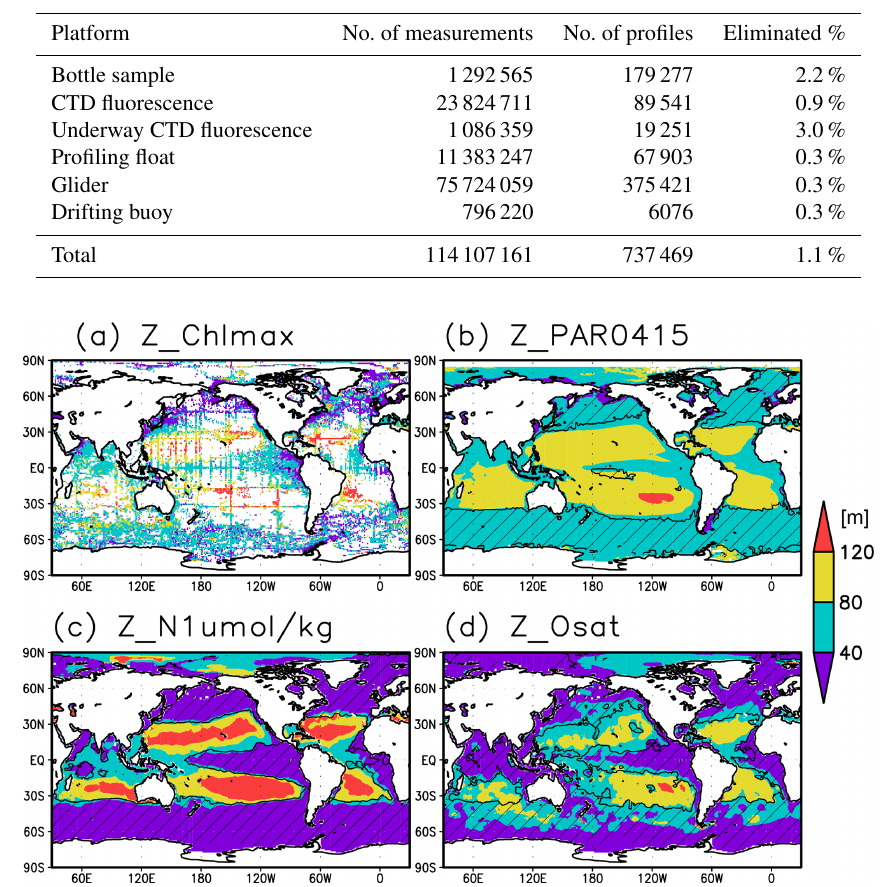
Figure 2. Depths of (a) the chlorophyll a (Chl a ) maximum, (b) the photosynthetically active layer ( > 0 . 415molm − 2 d − 1 of photosyn- thetically available radiation), (c) the nitrate-depleted layer ( < 1µmolkg − 1 of nitrate), and (d) the oxygen-oversaturated layer. The hatched areas show regions in which the mixed layer is deeper than the photosynthetically active layer in (b) , the nitrate-depleted layer in (c) , and the oxygen-oversaturated layer in (d)